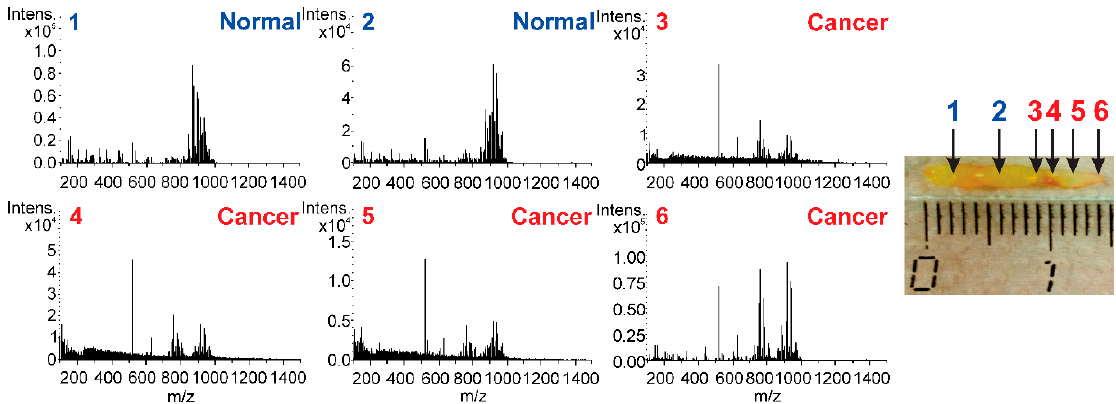
Figure 6. Positive-ion mass spectra at different points from one sample. Changes in MS profile correlate with shifting of the surgical probe from normal to tumor tissue. The figures in the photo indicate the points for which histological and LTEU-EESI-MS analyses were done.